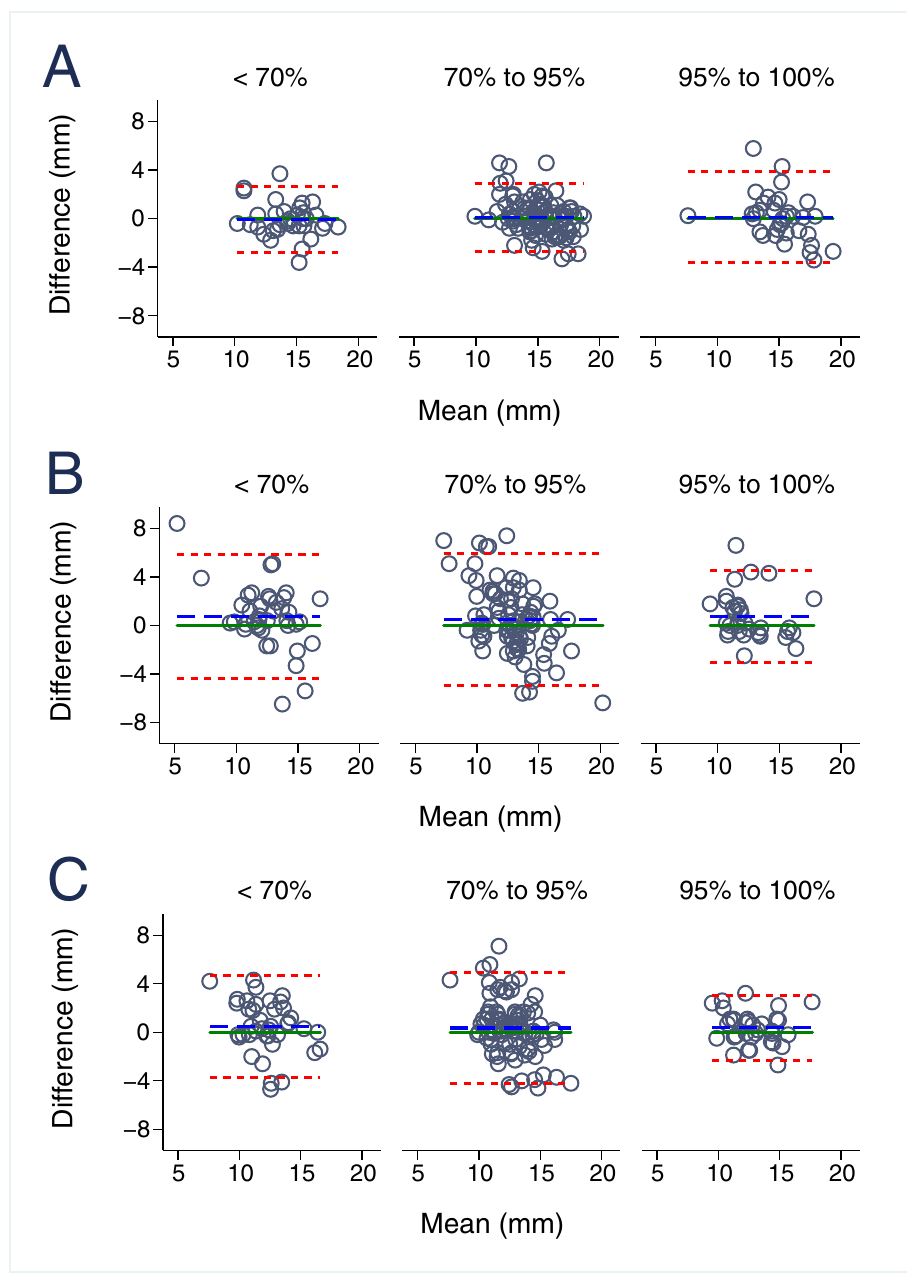
Fig 5. Intraobserver reproducibility of MAPSE imaging in relation to echocardiographic image quality. A. Intraobserver variability for m-mode derived MAPSE, B. Intraobserver variability for B-Mode lateral derived MAPSE, C. Intraobserver variability for B-Mode septal derived